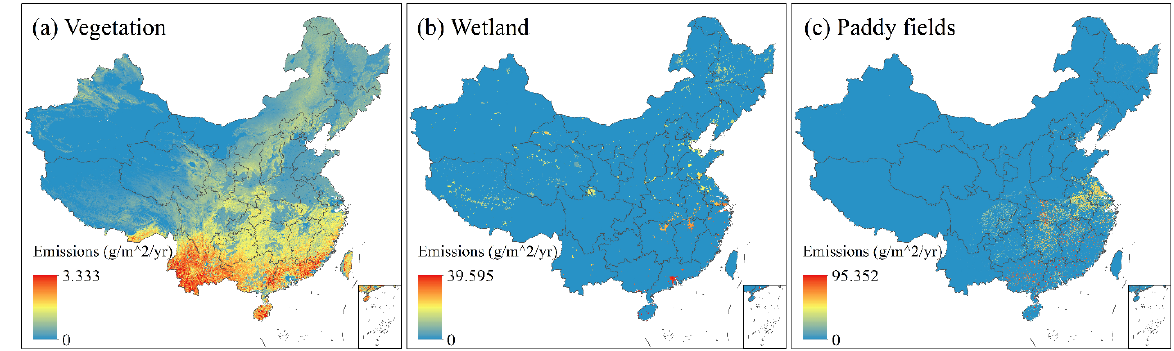
Figure 3. ( a ) Map of CH 4 emissions from vegetation; ( b ) Map of CH 4 emissions from wetland; ( c ) Map of CH 4 emissions from paddy fields. Table 5. Monthly and total CH 4 emissions from terrestrial ecosystems in China,